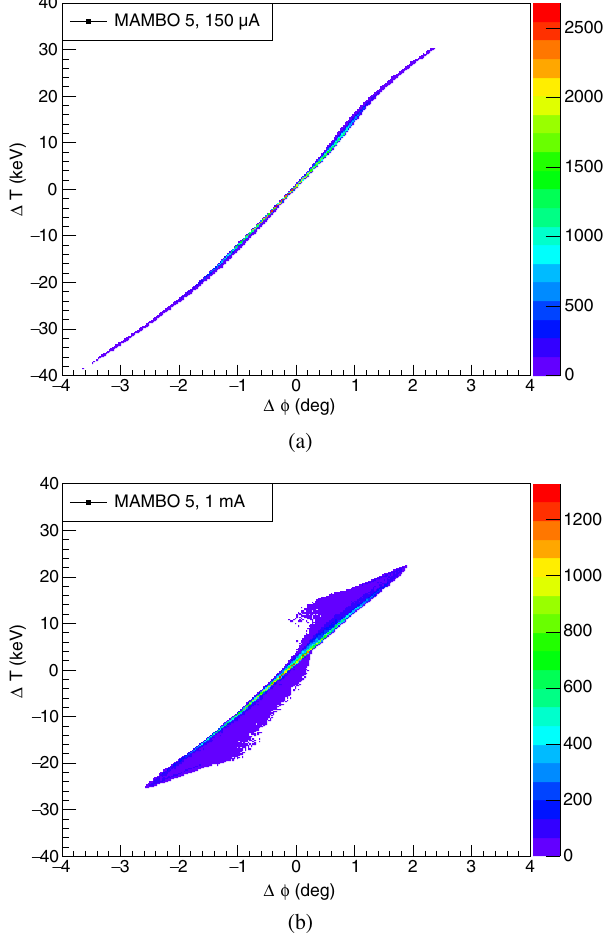
FIG. 9. Particle distributions in longitudinal phase space of different beam currents at the end of the normal conducting MAMBO version 2 with a post-buncher (Fig. 9a: I ¼ 1 and Fig. 9b: I b